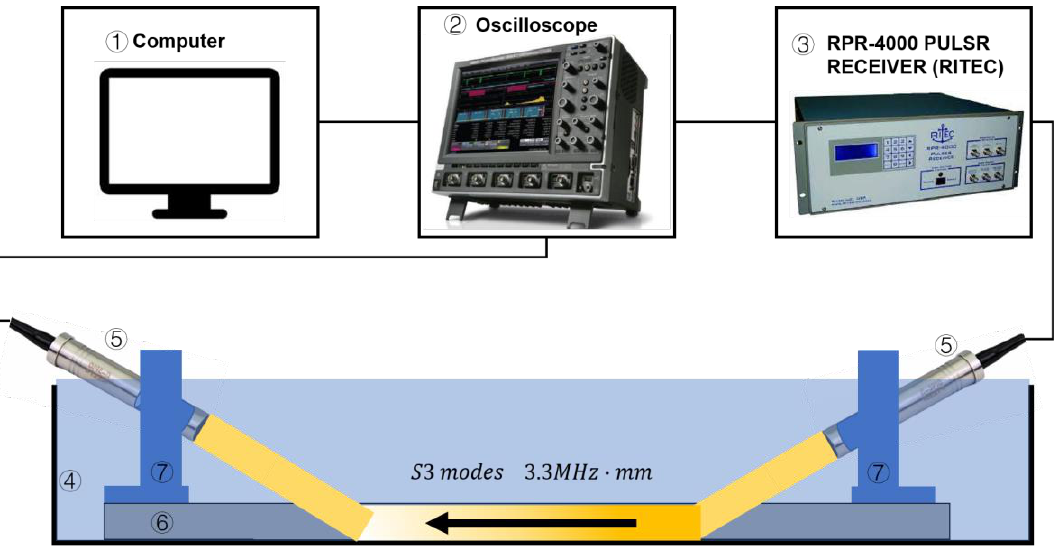
Figure 3. Experimental setup: ① Computer; ② Lecroy oscilloscope; ③ Pulser receiver; ④ Water tank; ⑤ Piezo electric immersion transducer; ⑥ Specimen; and ⑦ Transducer holder.